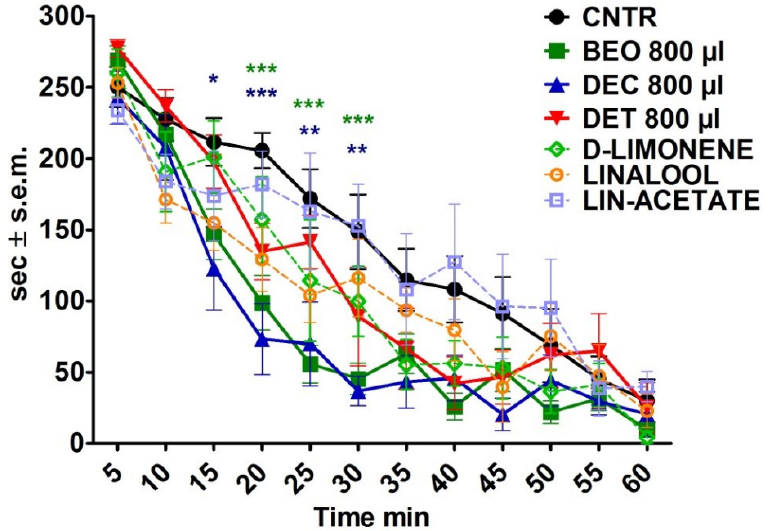
Figure 2. Time course of the effects of the bergamot essential oil (BEO), of the decolored (DEC) and deterpenated (DET) fractions, and of D-limonene, linalool, and linalyl acetate on locomotor activity in seconds (sec) at 5 min intervals. Two-way ANOVA followed by Bonferroni test; n = 8, * p < 0.05, ** p < 0.01, *** p < 0.001.